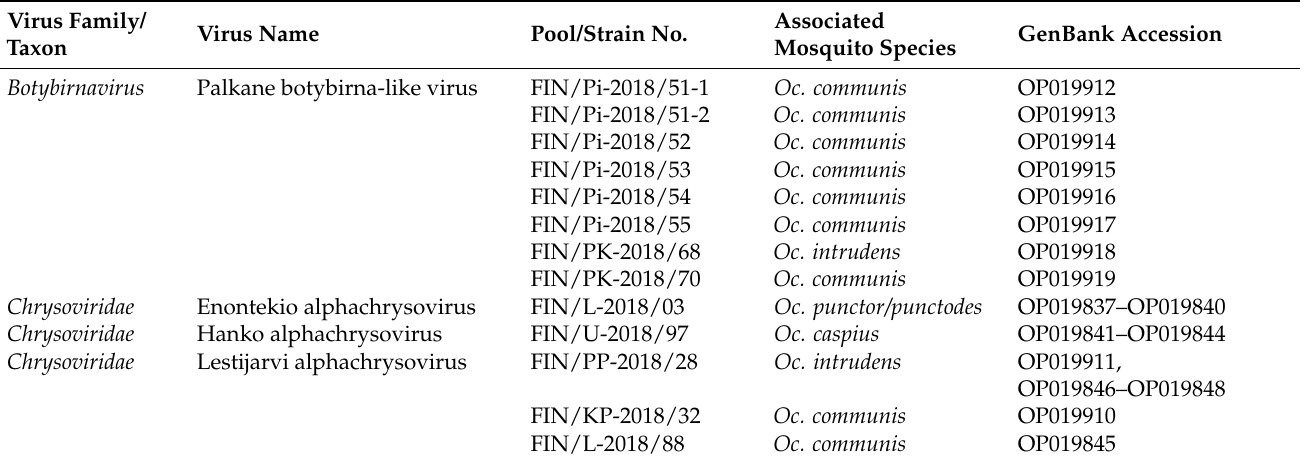
Table 5. dsRNA viruses sequenced from Finnish mosquitoes, part